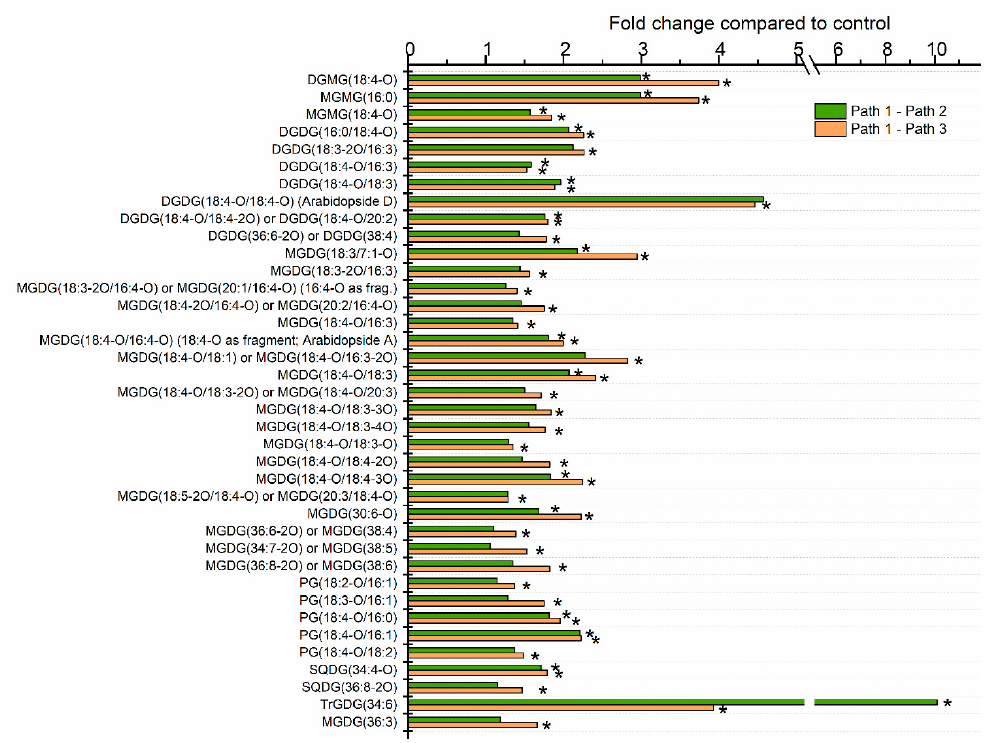
Figure 4. Plastidically-formed oxidized di- and monoacylglycerol leaf lipids, significantly altered by heat treatment. Values represent the level of each lipid under heat treatment over the level in control plants at 16 h after the start of the experiment. Control plants were maintained at 21 °C (Path 1), while Path 2 plants were subjected to 12 h at 38 °C plus 4 h at 45 °C, and Path 3 plants were subjected to 12 comparisons were made between paths; p -values were adjusted for FDR. The lipid species shown were those significantly altered in Path 2 and/or 3 compared to Path 1, as indicated by asterisks on the bar